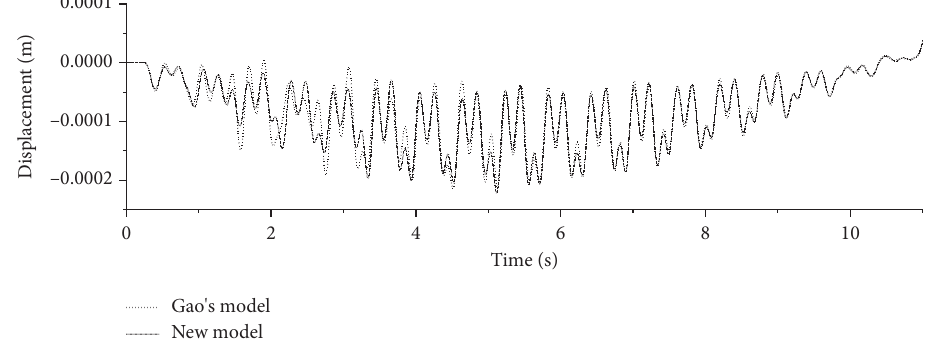
Figure 6: Displacement of the beam at mid-span (initial vector not optimized).